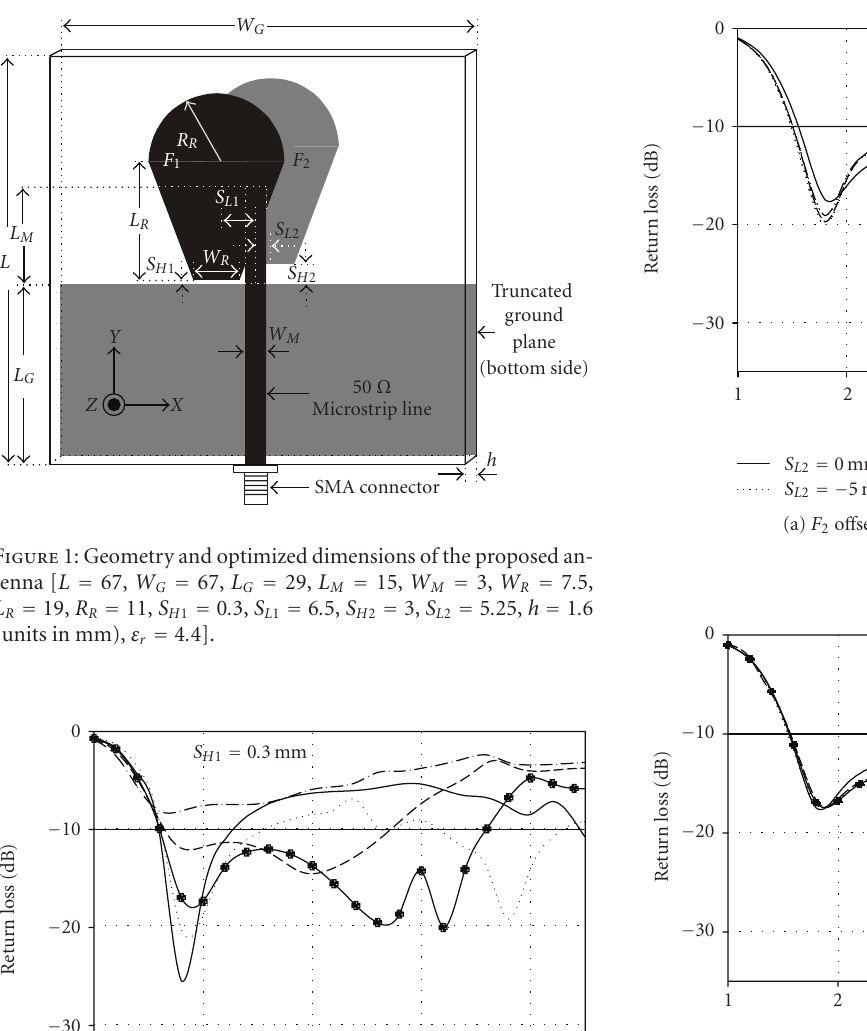
etched on a substrate of relative permittivity ε r = 4 . 4 and thickness h = 1 . 6 mm. The radiating patches have a base width W R = 0 . 082 λ (7.5 mm), length L R = 0 . 208 λ (19 mm),